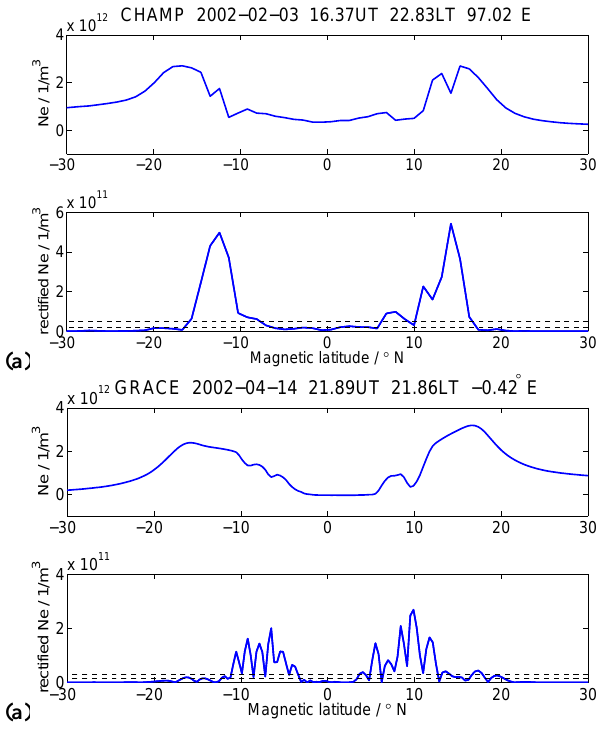
Fig. 3. Examples of bubble detected from PLP data and KBR data in the top and bottom frames, respectively. The dashed lines in both lower panels represent the upper (LU) and lower levels (LL) applied for the automatic EPBs detection process.